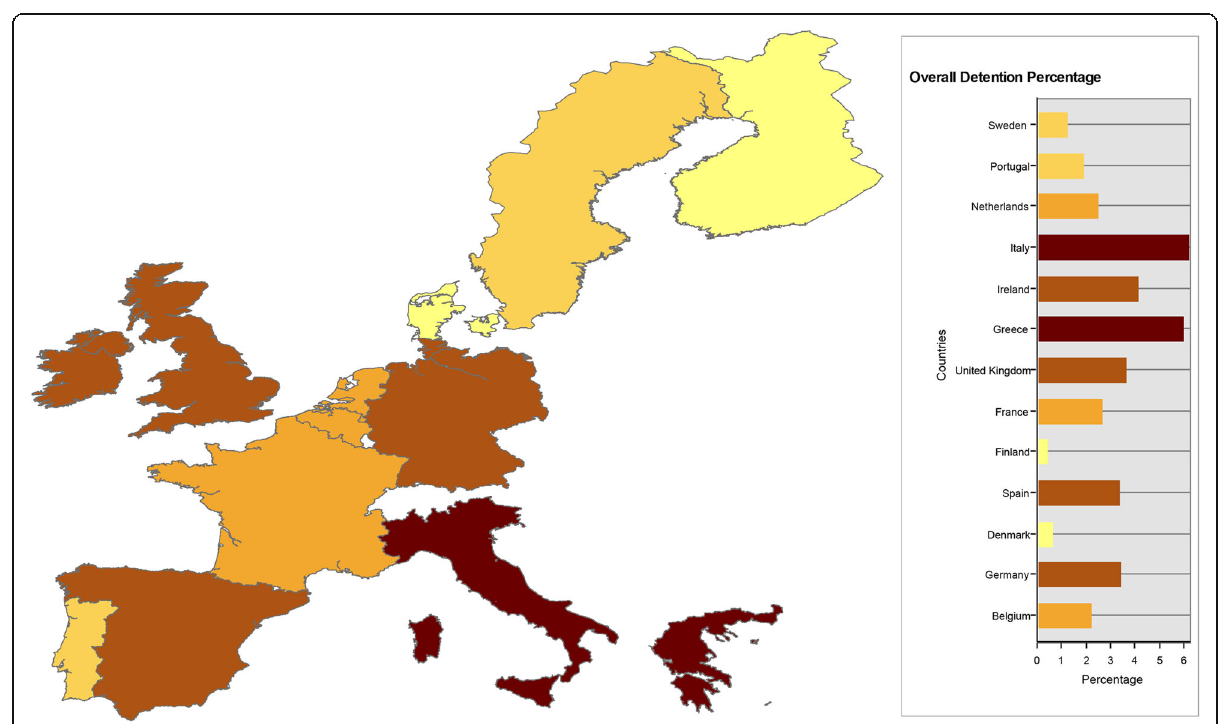
Fig. 3 Overall detention percentage for EU15